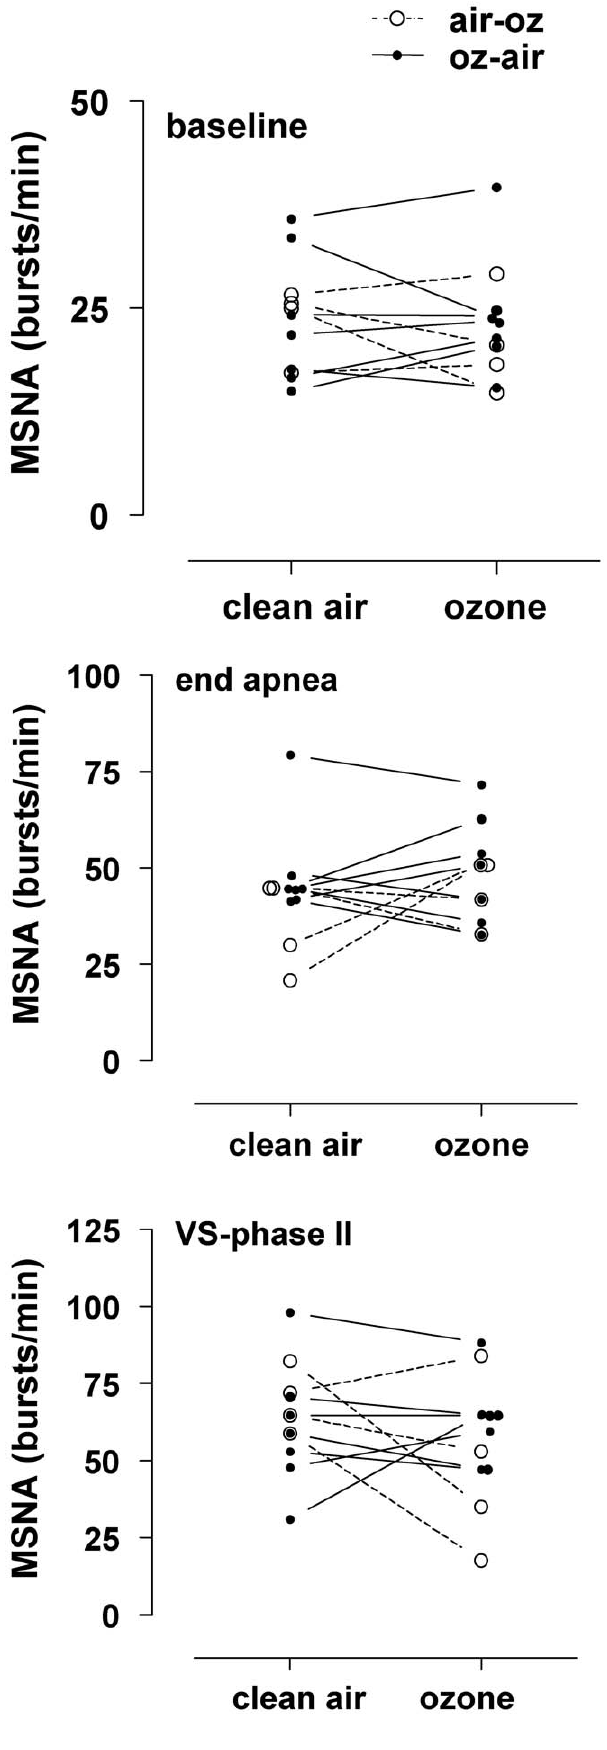
Figure 2. Individual values of muscle sympathetic nerve activity (burst frequency in bursts/min) measured after clean air and ozone exposure at rest (top), at the end of maximum inspiratory apnea (middle) and during late phase II of the Valsalva maneuver (bottom) for subjects exposed first to clean air (empty circles, n=4) and for subjects exposed first to ozone (filled circles, n=7).